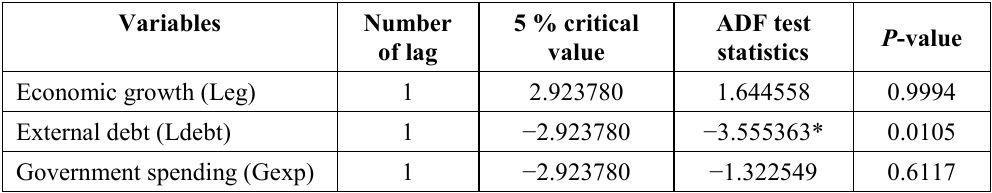
Table 2 . Augmented Dickey-Fuller (ADF) test at series